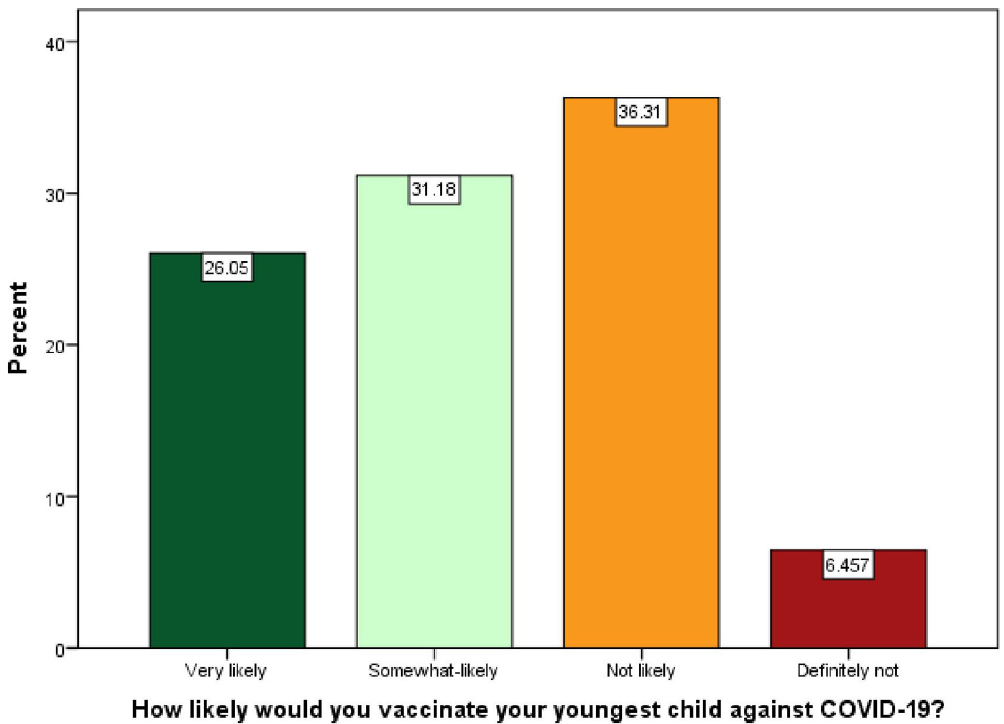
Figure 1. Likelihood of COVID-19 vaccine acceptance/refusal by Bangladeshi parents for children aged